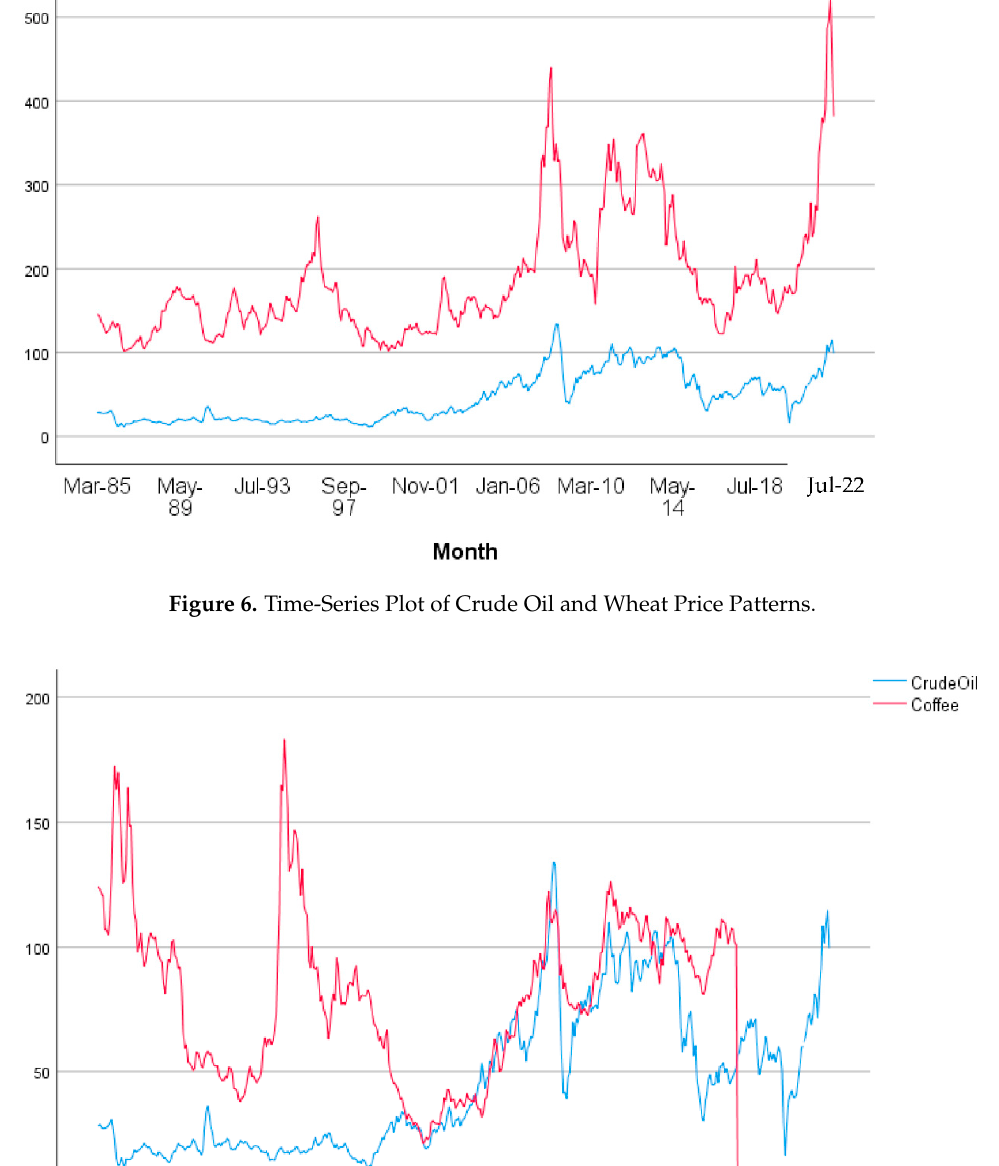
Figure 8. Time-Series (Logarithmic) Plot of Crude Oil and Beef Price Patterns.